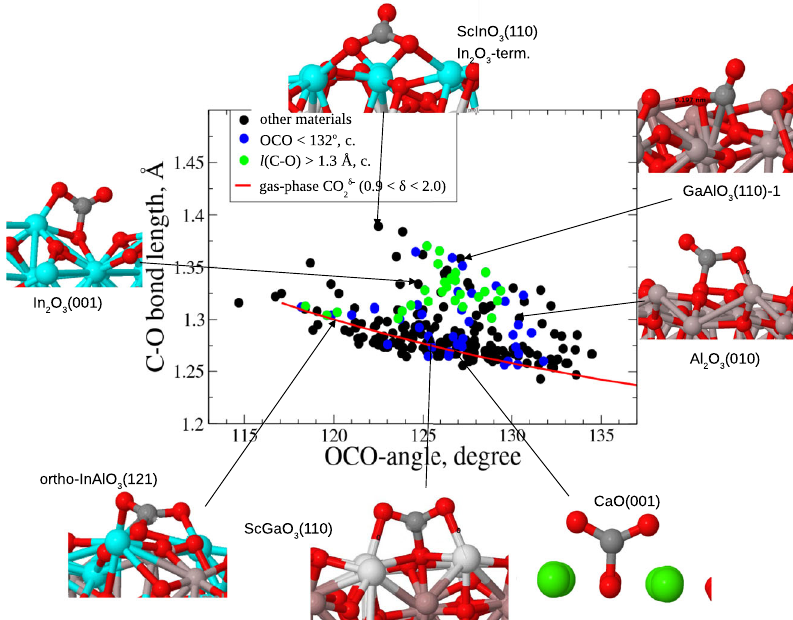
Fig. 1 Correlation between the larger of the two C – O bond lengths and the OCO-angle for charged gas-phase and adsorbed CO 2 . The OCO-angle in charged gas-phase CO 2 is shown with the red line, and adsorbed CO 2 structures are shown with the dots. Colored dots: blue — adsorption sites from the unconstrained subgroup with OCO < 132°, green — subgroup of sites with l (C – O) > 1.30 Å, black — the remaining samples (see the text). The subgroups obtained with Sabatier principle constraint are marked with “ c ”